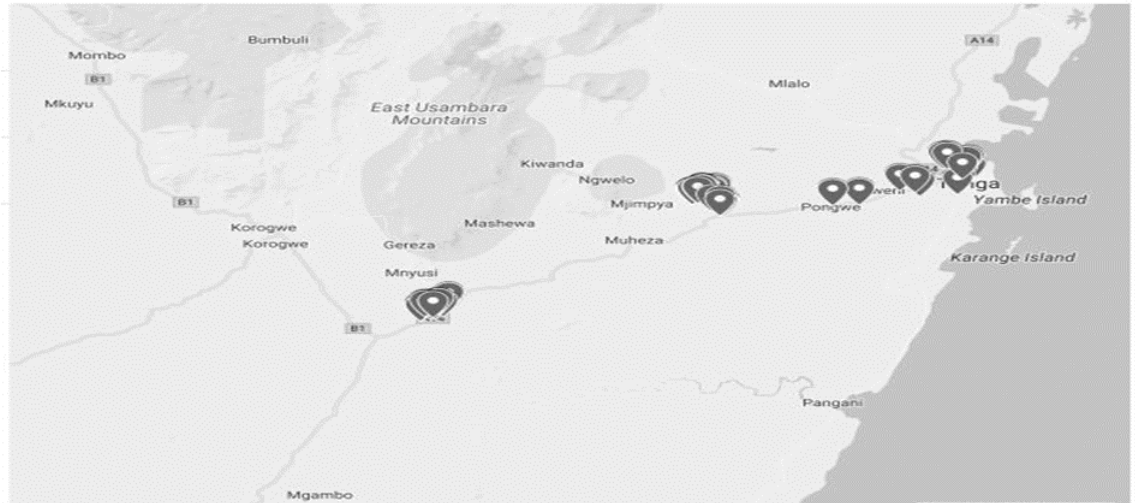
Figure 1. Description of the study area,